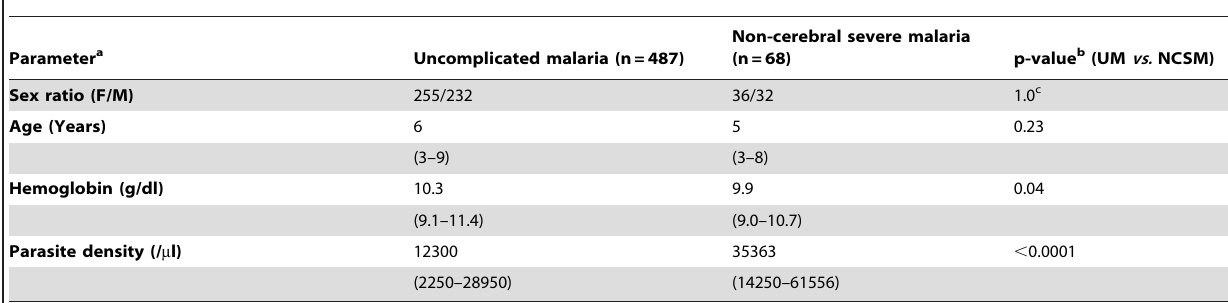
Table 1. Demographic and clinical characteristics of patients.